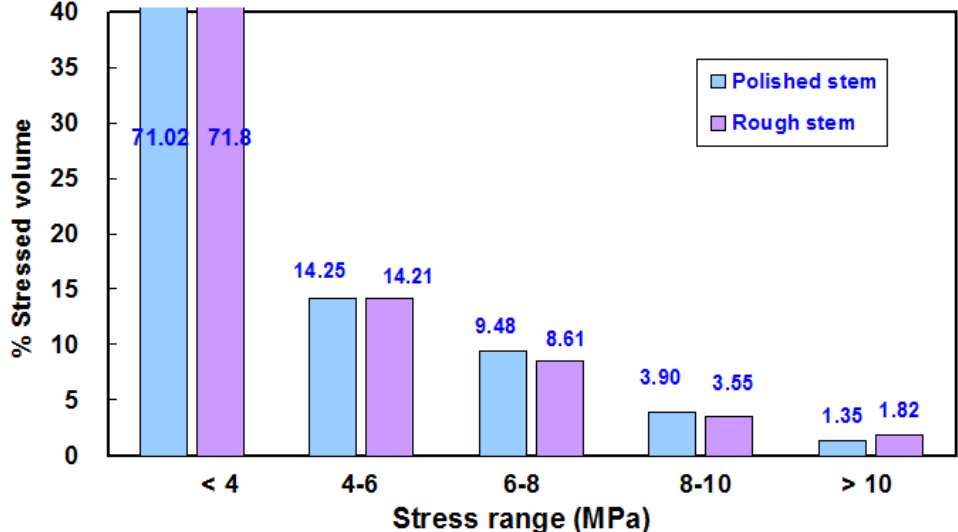
Figure 8. Comparison of the stressed volume of cement mantle at different stress range produced by the stem with smooth and rough stem.